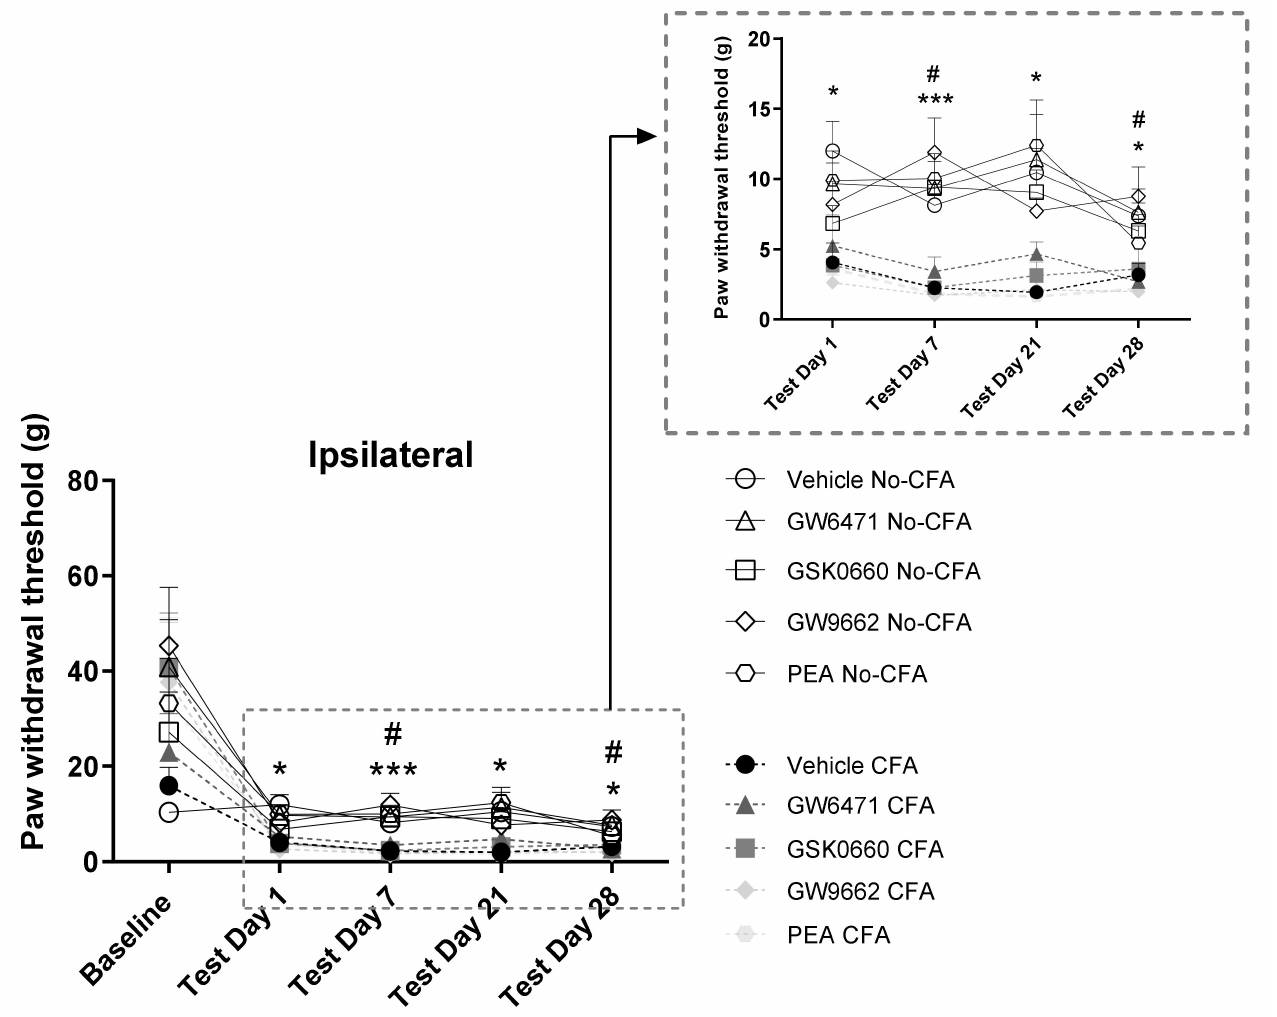
Figure 3. Effects of systemic administration of vehicle, selective PPAR α (GW6471), PPAR β / δ (GSK0660) and PPAR γ (GW9662) antagonists, and PEA on mechanical hypersensitivity in CFA-injected (CFA) and control (No-CFA) rats. Post hoc testing indicated significantly lower paw withdrawal thresholds in CFA vehicle-treated animals on days 1, 7, 21, and 28 (* p < 0.05 and *** p < 0.001, vs. No-CFA Vehicle) in the ipsilateral paw (B). The test also indicated lower paw withdrawal thresholds in CFA GW9662 and PEA-treated animals compared to their No-CFA counterparts (# p < 0.05 vs. No- CFA GW9662, days 7 and 28; # p < 0.05 vs. No-CFA PEA, days 7 and 21). The von Frey data, which were non-parametric, are presented in timeline graphs as means ± S.E.M. for presentation/readability purposes ( n = 7–8 rats per